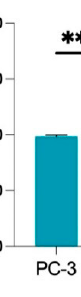
Figure 5. Impact of MM10 on glutathione levels in prostate cancer cells. ( A ) Impact on GSH/GSSG ratio of PC-3 cells after 24 h exposure to MM10 (1 µM). ( B ) Impact on GSH/GSSG ratio of DU-145 cells after 24 h exposure to MM10 (1 µM). ( C ) Impact on GSH tot level of PC3 cells after 24 h exposure to MM10 (1 µM) or L-BSO (25 µM). ( D ) Impact on GSH tot level of DU-145 cells after 24 h exposure to mito-metformin10 (1 µM) or L-BSO (25 µM). L-BSO is an inhibitor of glutathione biosynthesis used as positive control. Bars represent means ± SEM (µM/mg of proteins), (*) p < 0.05, (**) p < 0.01, (ns) non-significant, Student’s t test, N = 3. 2.4. MM10 Alleviates Tumor Hypoxia in the PC-3 Cancer Model As we observed in vitro a significant decrease in OCR, we hypothesized that MM10 could lead to an increase in tumor oxygenation in vivo, as it was observed previously for other compounds [23,35–37]. For the purpose, we measured the oxygenation in PC-3 tu- mors by in vivo EPR oximetry. We found out that PC-3 tumors were highly hypoxic as the initial pO 2 before treatment was lower than 2 mmHg (Figure 6). When mice were treated daily with MM10 (IP injection, 2 mg/kg), a sharp increase in tumor oxygenation was observed 24 h after treatment initiation and the tumor oxygenation remained higher than basal pO 2 up to 72 h (Figure 6).